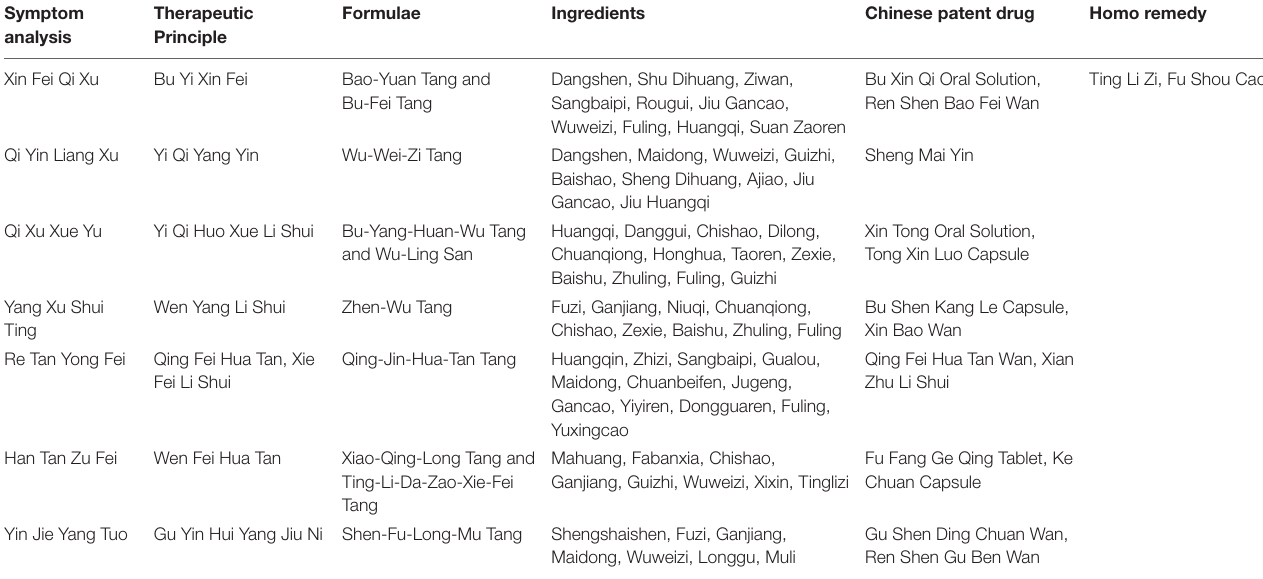
TABLE 4 | Formulae for heart failure based on syndrome